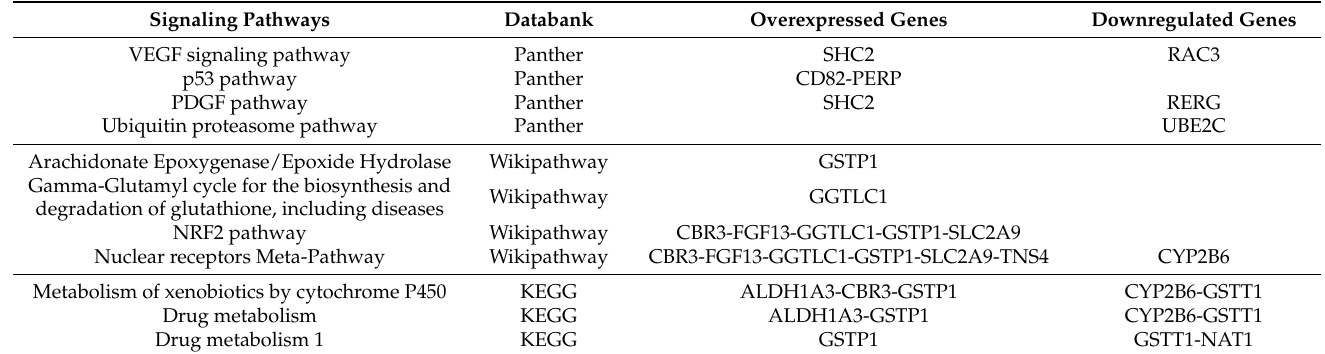
Table 4. Signaling pathways related to the genes differentially expressed associated with